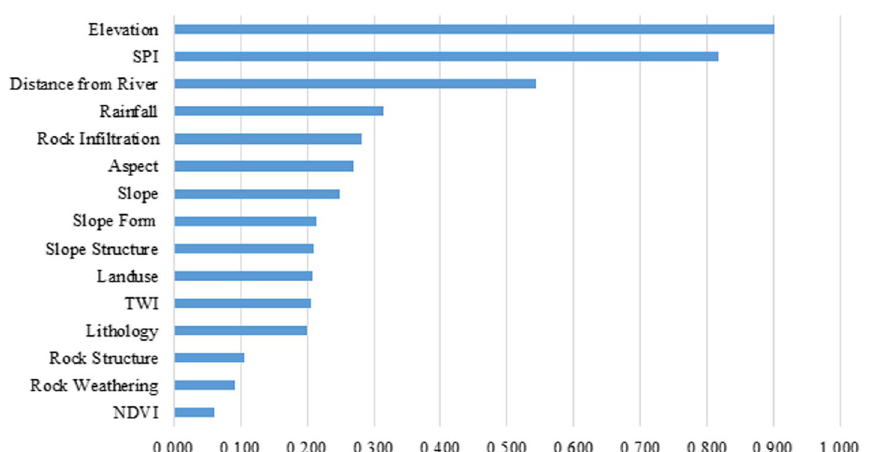
Figure 7. The Relief-F coefficients for 11 basic factors and 4 rock–soil characteristic factors.